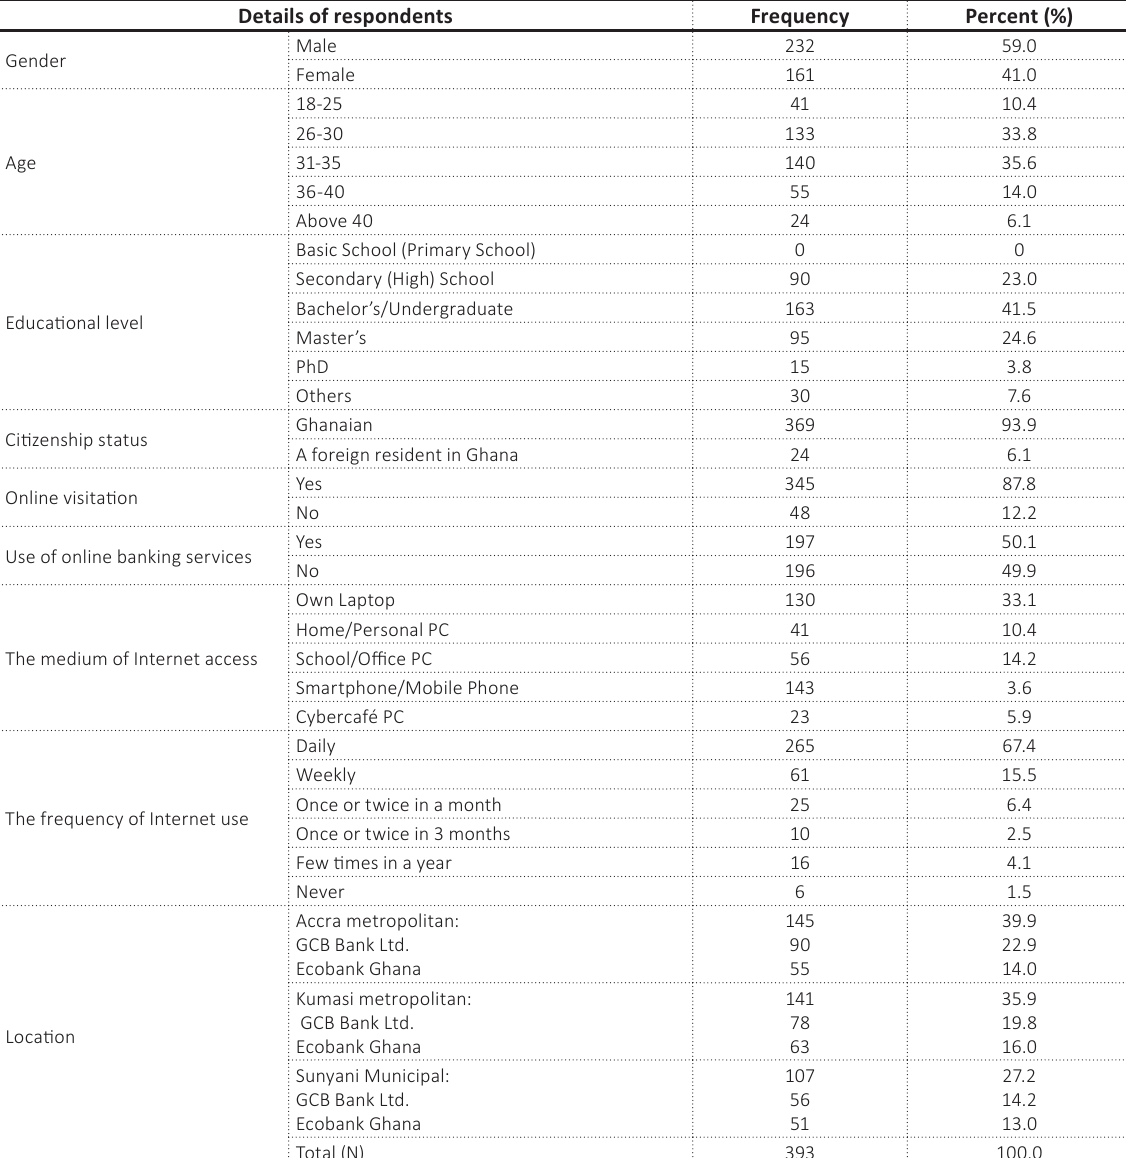
Source: Field survey, November 2019 to February 2020, in